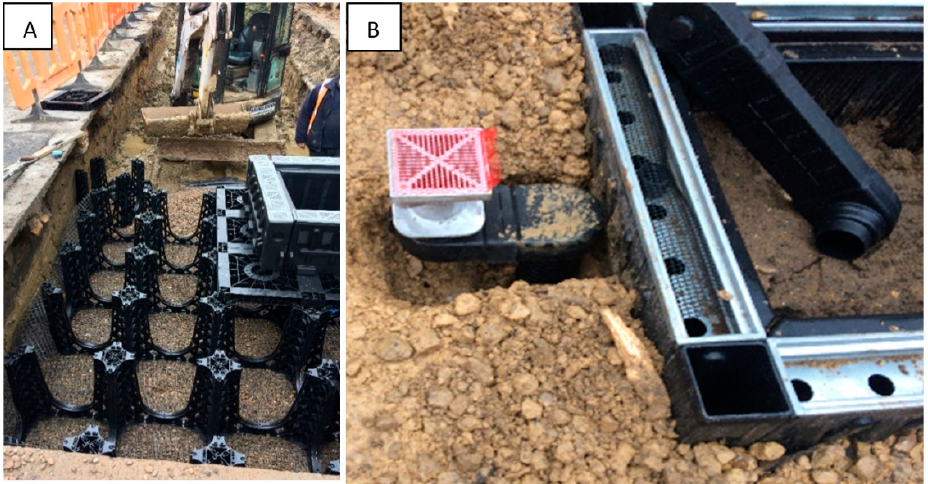
Figure 4. Photographs of the installation of two tree pit sustainable drainage systems (SuDS) in County Durham, including: ( A ) modular “RootSpace” cell system and; ( B ) one of the tree pit’s aeration vents.